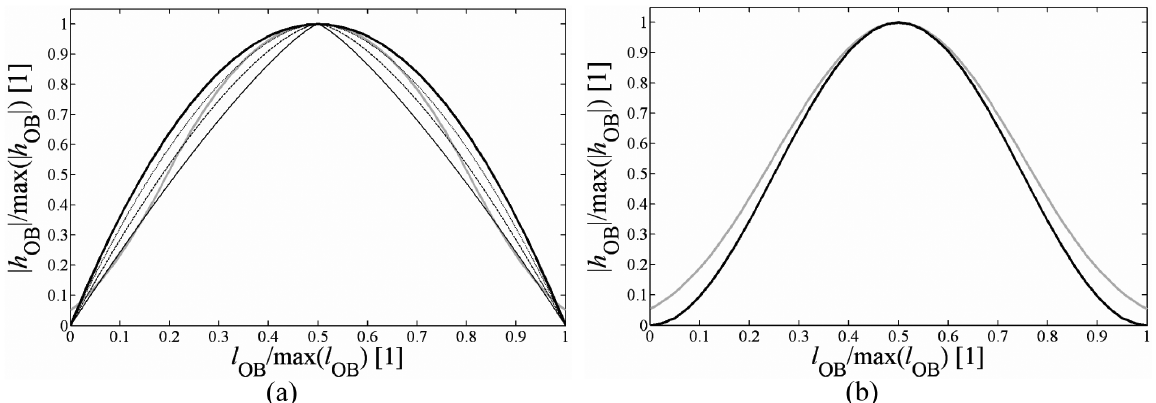
Fig. 4. Comparison of primary and MA- fi ltered obstacle shapes: (a) parabolic ( ), MA- fi ltered parabolic ( ), power(1.25)